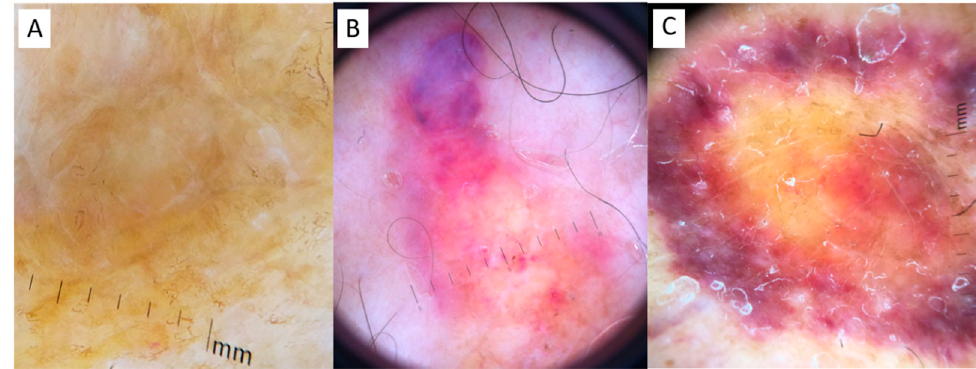
Figure 2. Dermoscopy. ( A ) Case 1: a structureless yellow background interspersed with whitish scar-like strikes in Case 1; ( B ) Case 2: roundish yellow waxy blotches on a hemorrhagic background, interspersed with fine telangiectasias and hemorrhagic spots; ( C ) Case 3: structureless yellow background interspersed with whitish spots, surrounded by a hemorrhagic halo with elongated serpentine vessels.